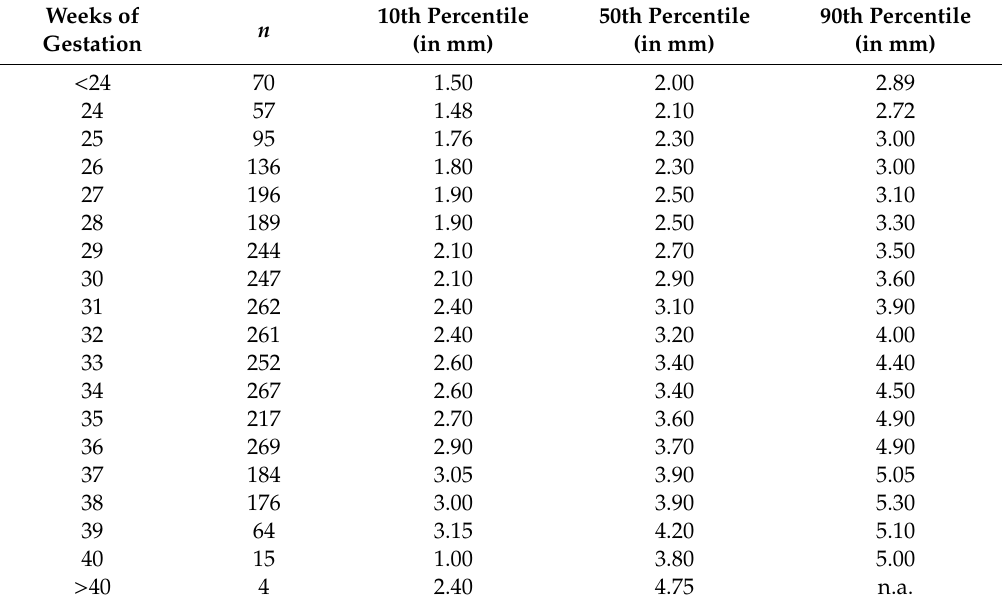
Table 3. FAST percentiles based on 3205 measurements of a Caucasian GDM